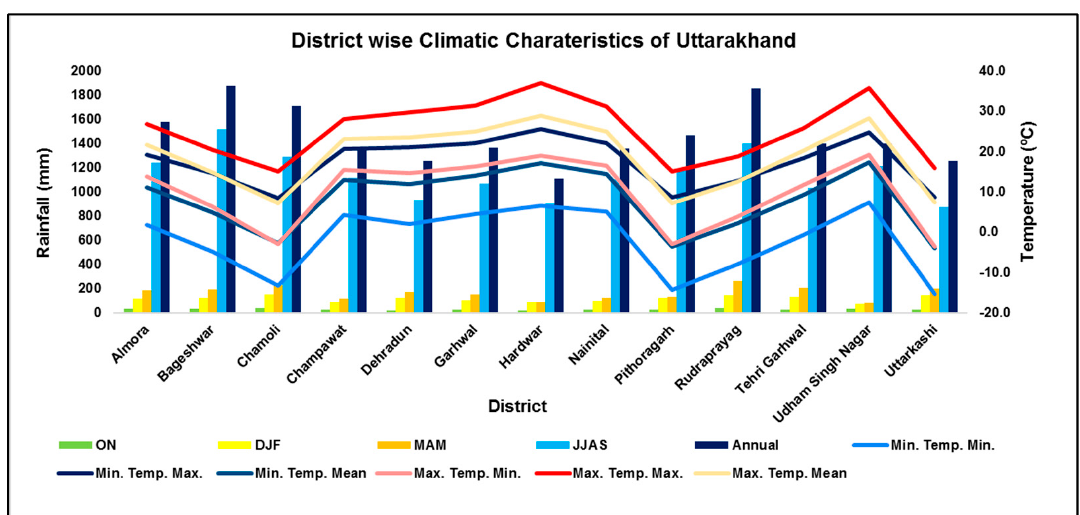
Figure 3. The climatic characteristics of various districts in Uttarakhand.